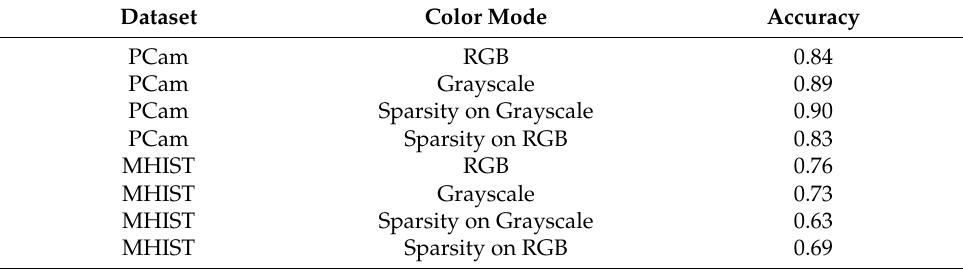
Table 4. Inference accuracy results of 32-bit-width training and inference on ResNet20.